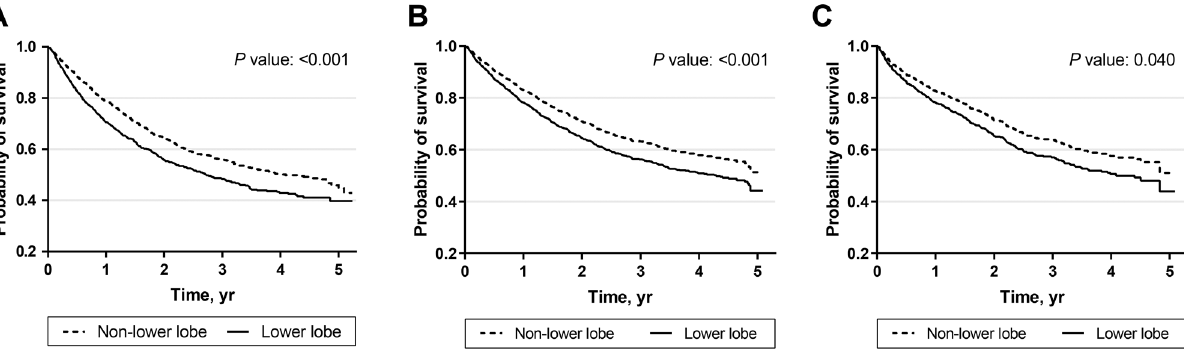
Figure 2. Kaplan–Meier survival curve with univariate model and multivariate Cox proportional hazard models. ( A ) Kaplan–Meier survival curve with univariate model; ( B ) Cox proportional hazard model 1 with the covariates except for the mediator candidates; ( C ) Cox proportional hazard model 2 with the covariates including the mediator candidates. The covariates included age, sex, smoking status, performance status, presence of symptoms, body mass index, standardized uptake value of main mass, stage, anaplastic lymphoma kinase translocation, and active treatment. The mediator candidates included adenocarcinoma histology, serum neuron-specific enolase level, serum cytokeratin fragment level, and epidermal growth factor receptor mutations.